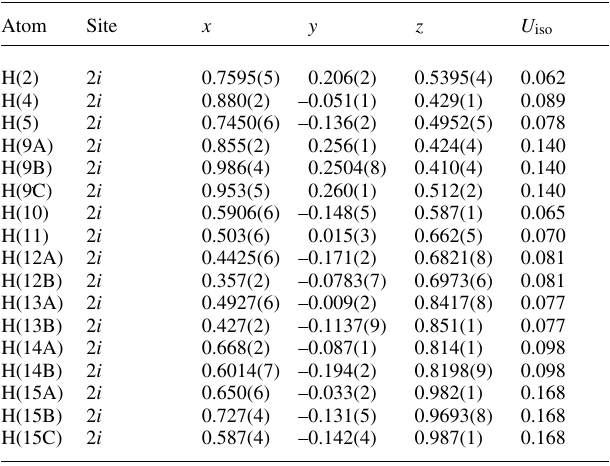
Table 2. Atomic coordinates and displacement parameters (in Å 2 )